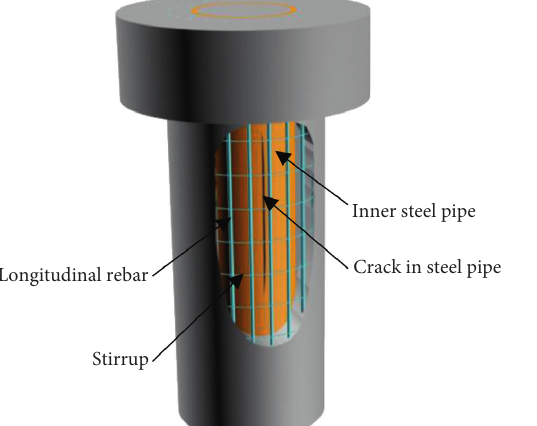
Figure 2: Crack in the inner steel pipe of column 5 on the 15 th floor.